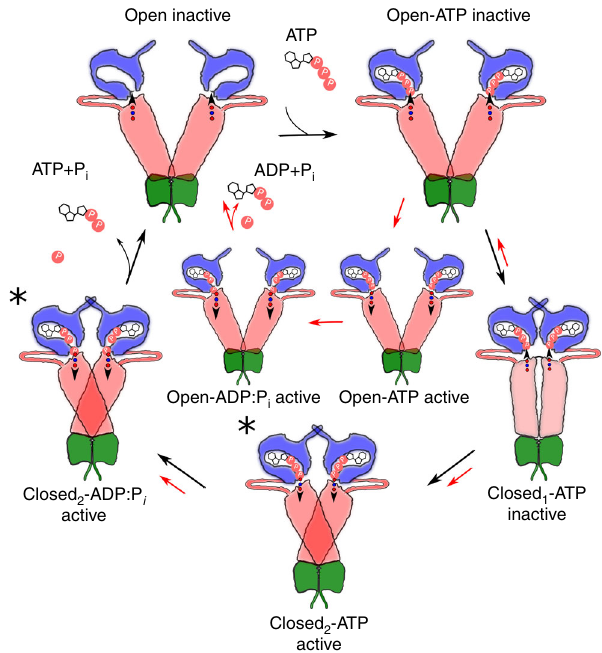
Fig. 6 Putative Hsp90 reaction cycle. ATP-binding to the open, catalytically inactive state, induces formation of a compact ATP-bound state (closed 1 -ATP inactive). Conformational changes (red/blue dots followed by arrow) within the NTD and M-domain lead to a catalytically active state (active) that triggers formation of a fully compact active form of Hsp90 (closed 2 -ATP active), with chaperone activity (marked with an asterisk). The hydrolysis reaction leads to splitting of the phospho- anhydride bond and formation of the closed 2 - ADP : P state, which further i dissociates to the open state. The R32A decoupling variant lowers the barrier for switching between inactive and active catalytic states that also lowers the ATP-hydrolysis barrier, but increases the free energy of forming the compact state (red arrows). The decoupling mutant could also run an ATP-hydrolysis cycle in parallel to the regular cycle that is fully decoupled from the formation of the closed form (red arrows). The NTD is shown in blue, the middle domain in red, and the CTD in